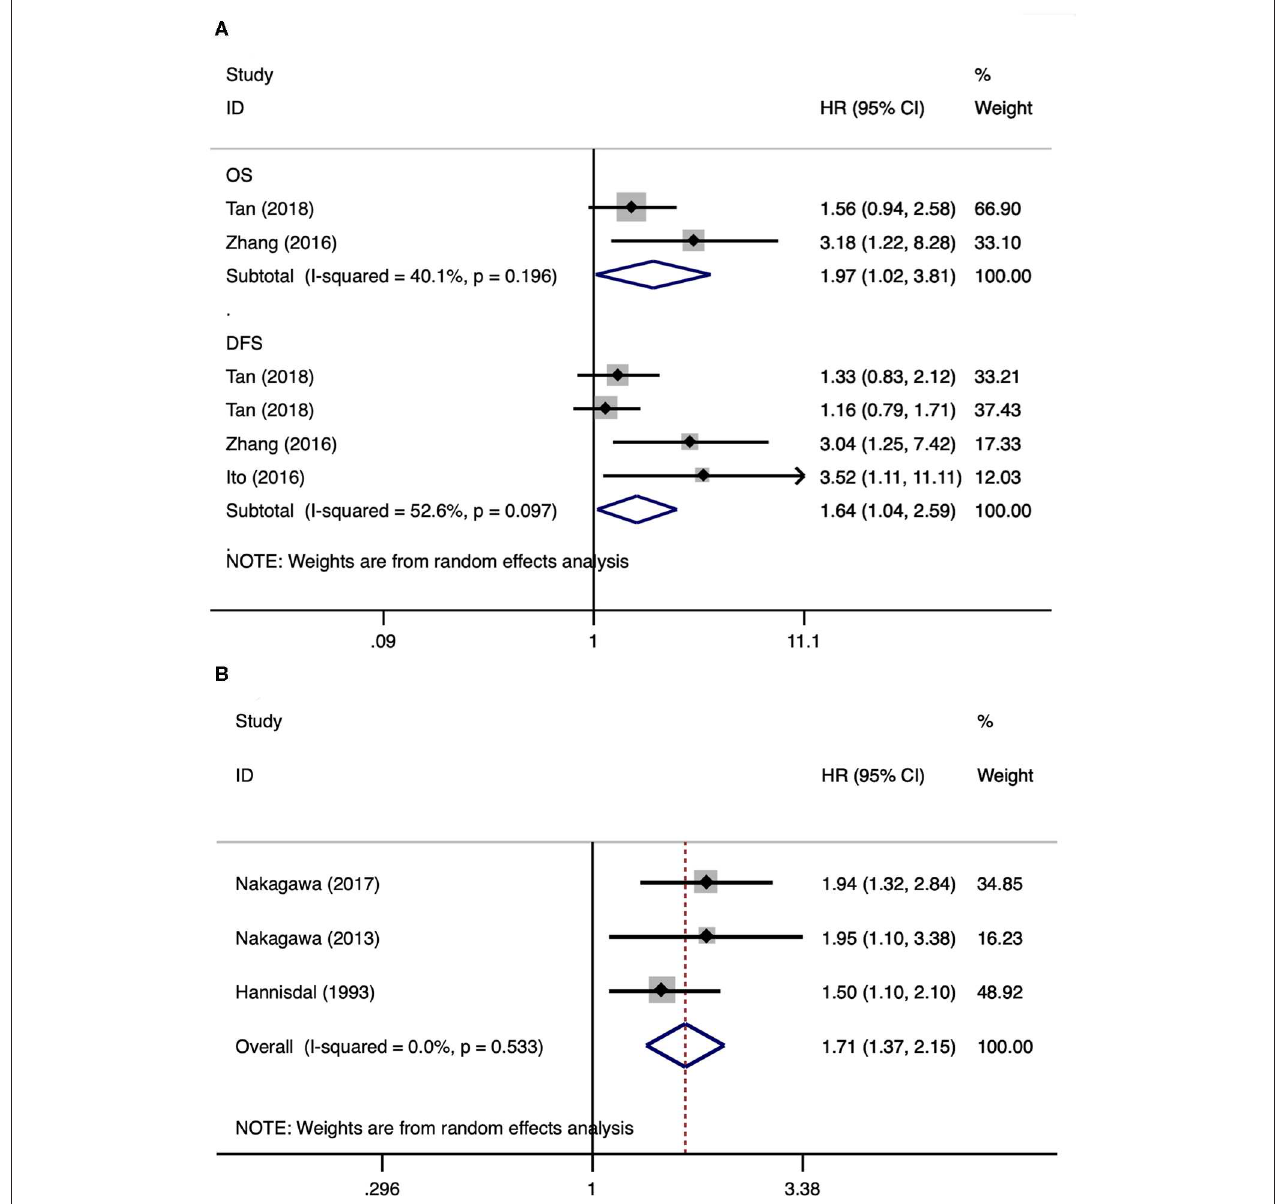
FIGURE 3 | Forest plots of studies about upper tract urothelial carcinoma and urothelial carcinoma of the bladder. (A) Upper tract urothelial carcinoma; (B) urothelial carcinoma of the